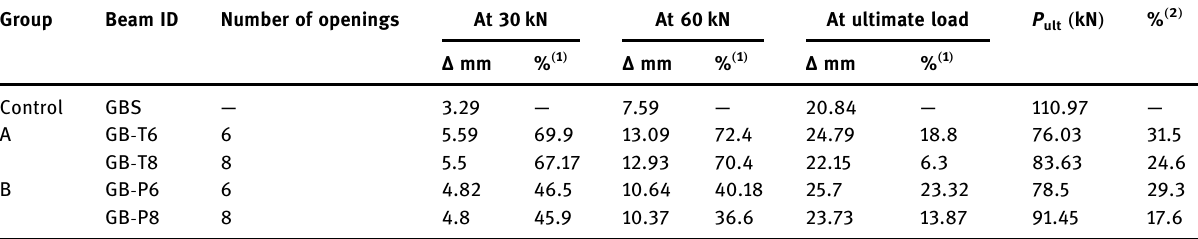
Table 6: Beams mid - span deformability at di ff erent loading stages Group